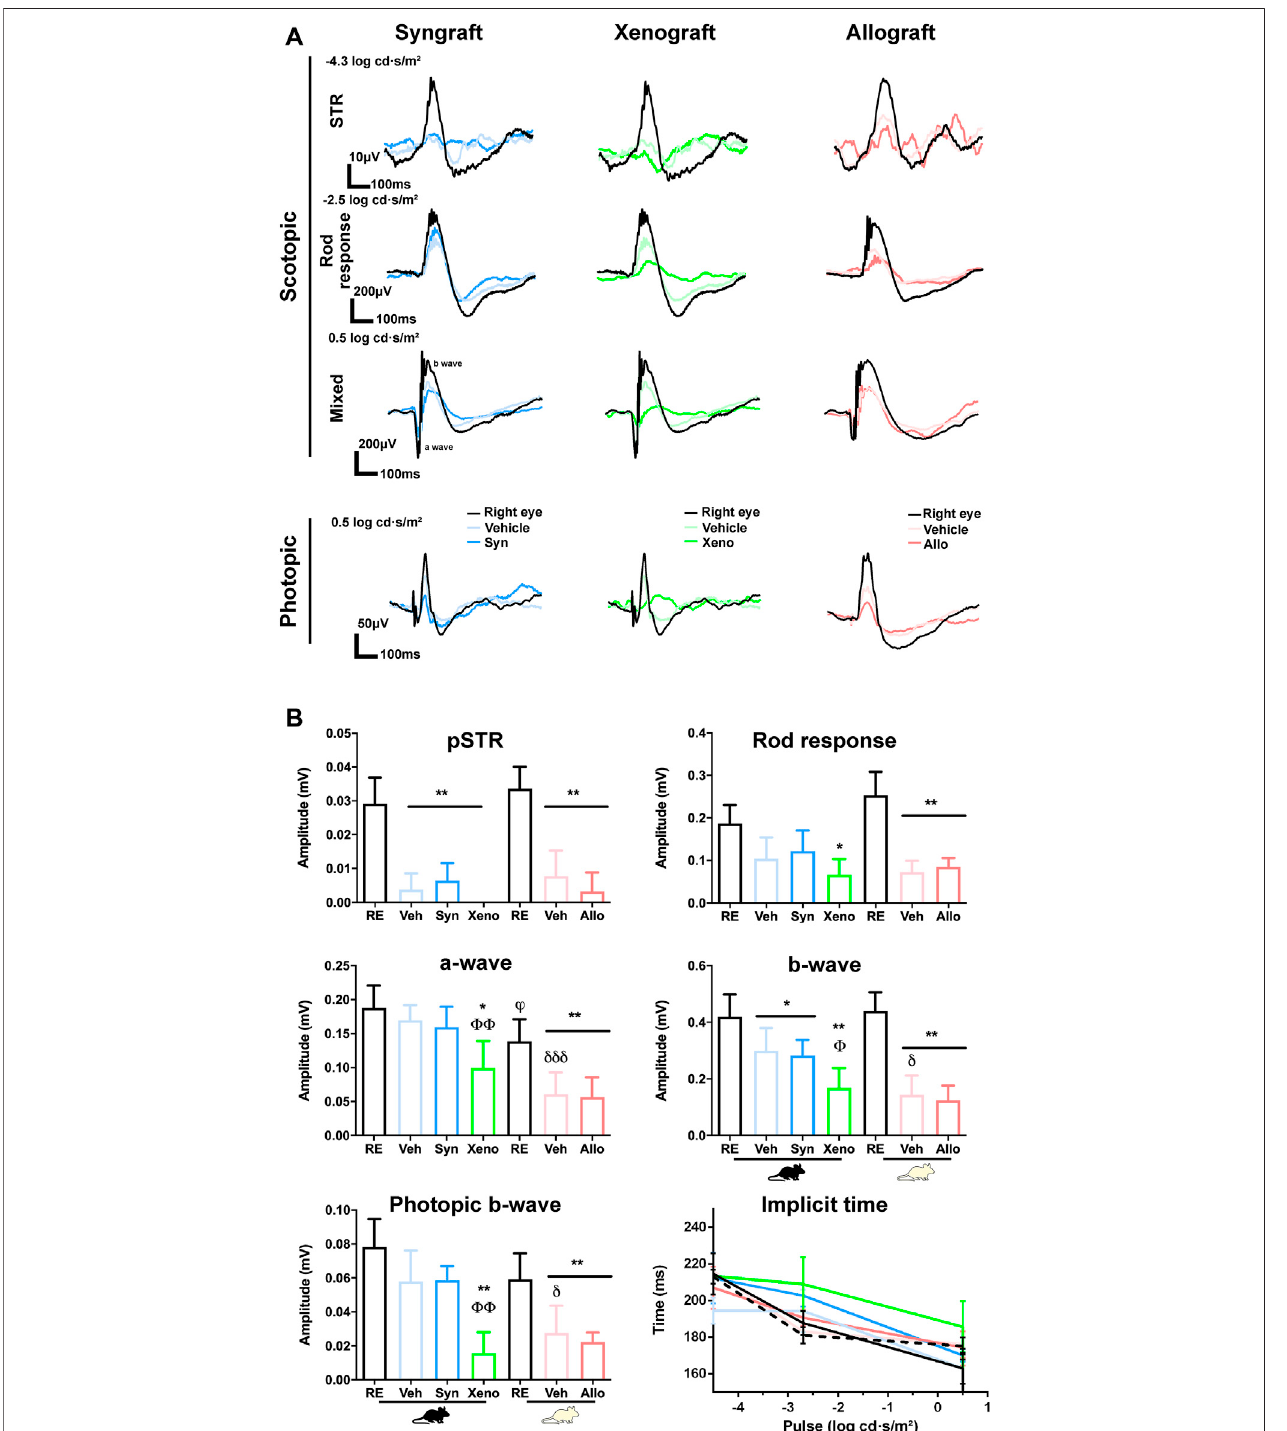
FIGURE8| Retinalfunctionalitydecreasesbyaxotomyandisfurtherimpairedbythexenograft.Electroretinographicanalysis90 daysafterONCandvehicleorBM- MSCs intravitreal administration. Right eyes were used as controls. (A) : ERG traces in scotopic and photopic conditions. (B) : Graphs showing the quanti fi cation of the positive scotopic threshold response (pSTR, RGCs), scotopic rod response (rod bipolar cells), scotopic mixed response (b-wave: cone and rod bipolar cells; a-wave: cones and rods), photopic b-wave (cone bipolar cells), and implicit time at the different light pulses. Implicit time: lines colour-coded as graphs (dashed black line: Balb/c, solid black line, C57/Bl6). RE: right eyes. Veh: ONC + vehicle. Syn: ONC + syngraft. Xeno: ONC + xenograft. Allo: ONC + allograft. Mouse silhouettes represent therecipientstrain.*Experimentalvs.righteyes(* p < 0.05,** p < 0.01Kruskal-Wallistest,Dunn ’ smultiplecomparisonstest). θ Xenograftedvs.ONC+vehicle( θθ p < 0.01, non-parametric Mann-Whitney test), φ albino vs pigmented right eyes ( φ p < 0.05, non-parametric Mann-Whitney test), δ Albino vs. pigmented ONC + vehicle eyes ( δ p < 0.05; δδδ p < 0.001, non-parametric Mann-Whitney test). 4 animals/group were recorded.